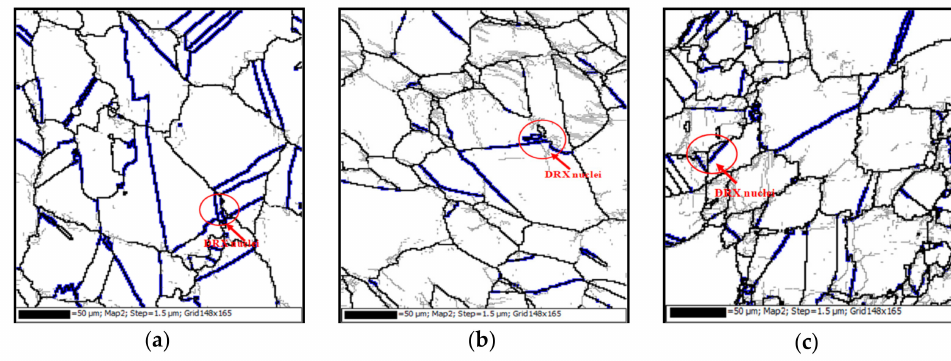
Figure 10. Orientation imaging microscopy maps at the strain of 0.27 and the deformation conditions of: ( a ) 1253 K, 0.001 s − 1 ; ( b ) 1253 K, 0.1 s − 1 ; ( c ) 1313 K, 0.01 s − 1 (LAGBs, HAGBs and annealing twin boundaries are indicated by thin-gray, thick-black, and thick- blue lines,